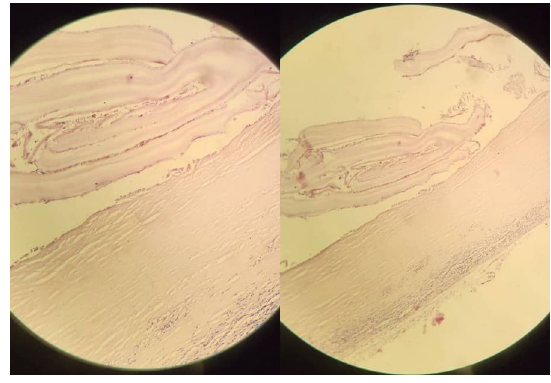
Fig. 4 Microscopic photo of the cystic